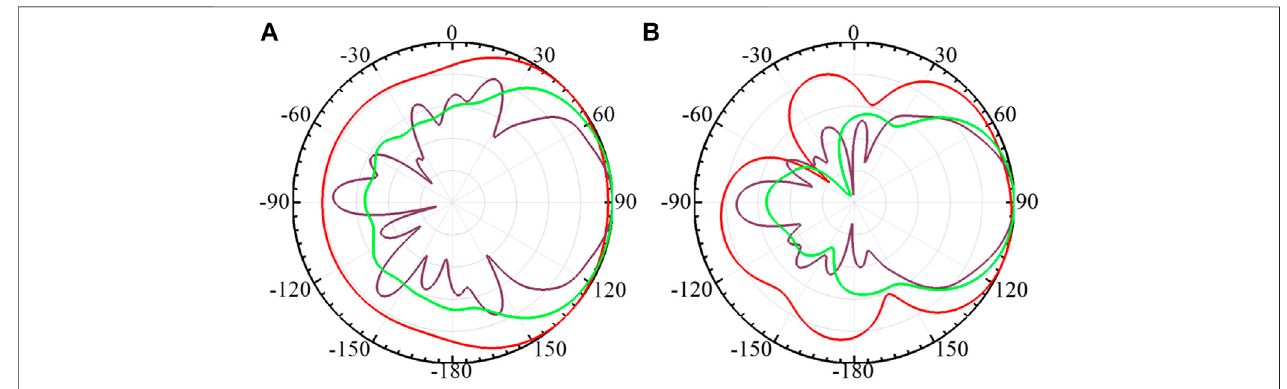
FIGURE 2 | (A) E-plane (B) H-plane Vivaldi antenna radiation pattern (red line is 1.7 GHz, green line is 3.3 GHz, and purple line is 4.9 GHz).